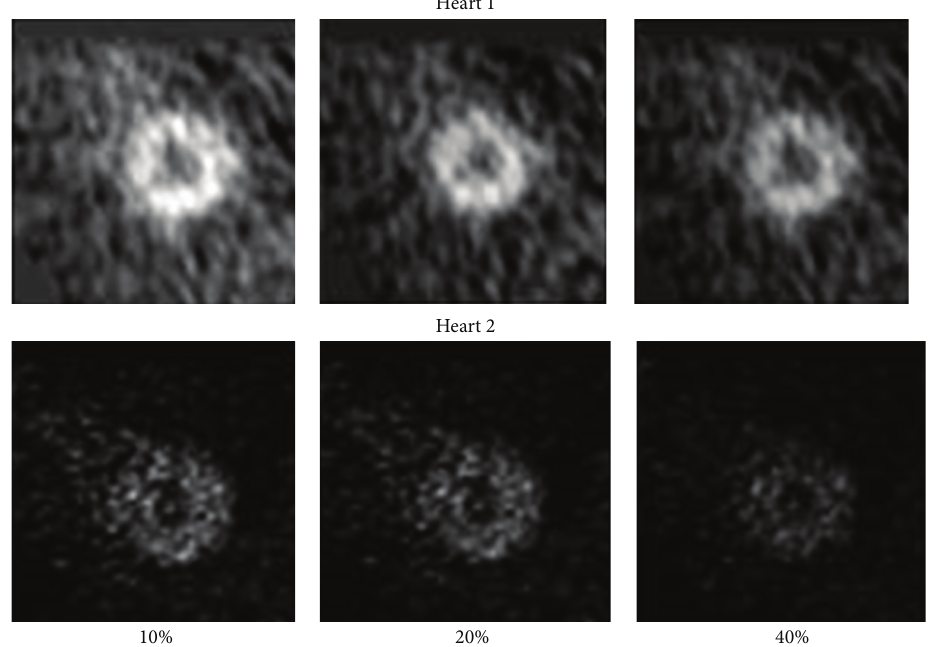
Figure 3: Mid ventricular slices of the images used in the image intensity sensitivity studies. These images represent the 10%, 20%, and 40% reductions in voxel